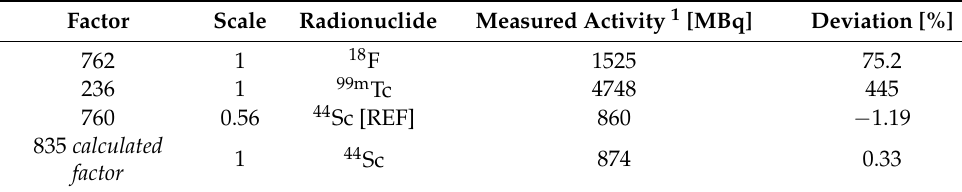
Table 5. Results obtained for the scandium-44 vial.